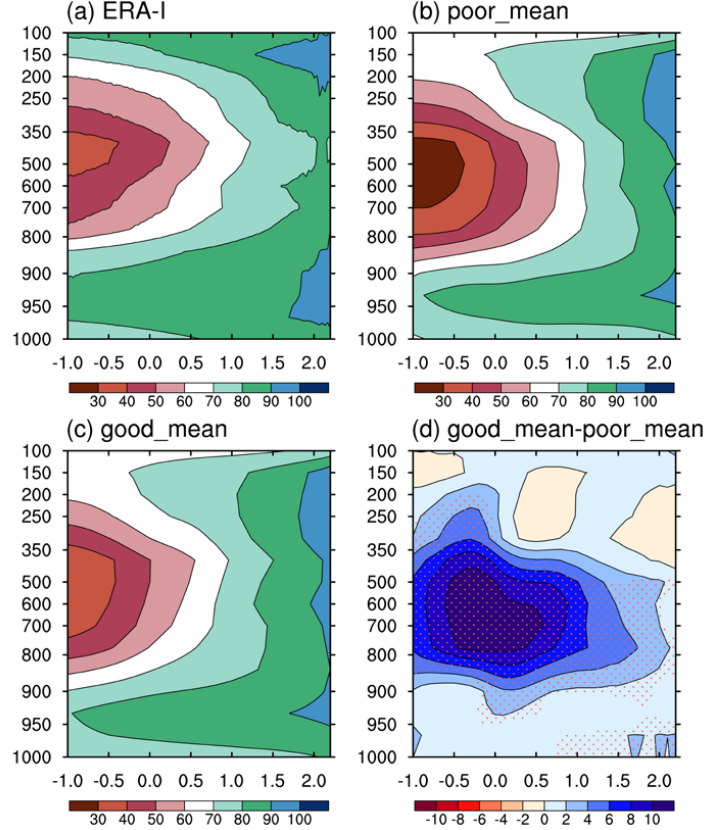
Figure 12. Composite vertical profiles of relative humidity as a function of precipitation rate over equatorial Indo-Pacific region (10 ◦ S–10 ◦ N; 50 ◦ –180 ◦ E) in ( a ) observation, ( b ) composite of poor simulations, ( c ) composite of good simulations and ( d ) the di ff erence between composites of good and poor simulations. The di ff erences reaching 90% confidence level are dotted. Noted that the precipitation rate on x axis is plotted on a log 10